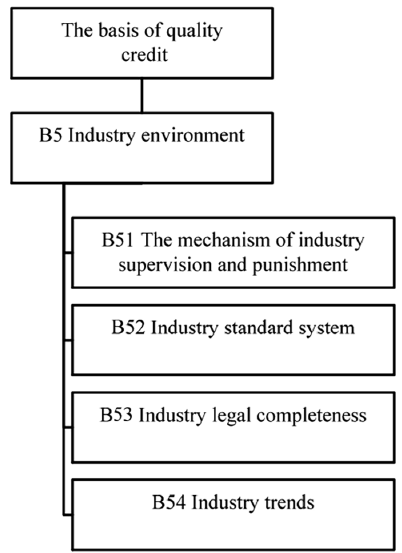
Figure 5. Hierarchy of quality credit